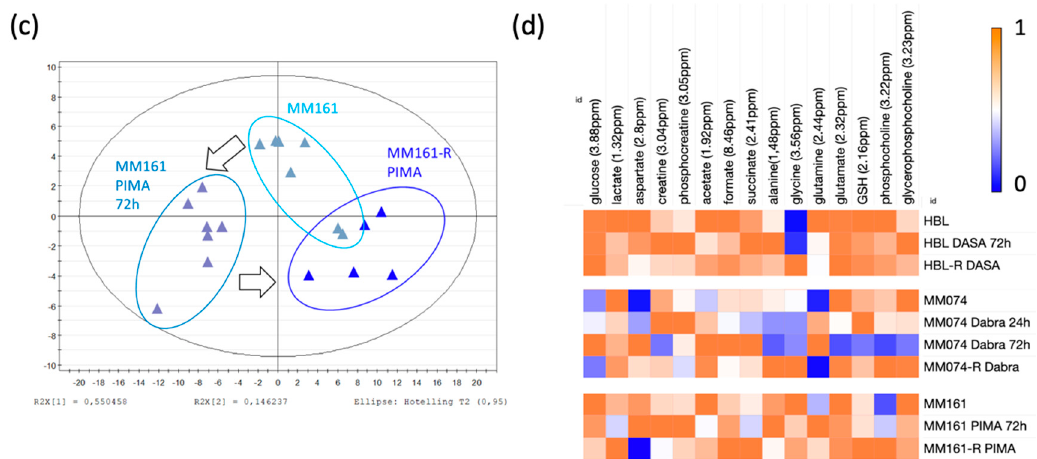
Figure 2. Scores plots highlighting the evolution of the IC metabolic signatures from an initial parental to a resistant status, in the case of mutant cKIT ( a ), mutant BRAF ( b ), and mutant NRAS ( c ) acquired resistance. Arrows were used to draw the metabolic switches followed by sensitive cells during resistance acquisition and exposed or not to targeted treatments. ( d ) Heatmap of the 15 IC discriminant metabolites identified between the 3 considered cell lines. Data normalization from [0 to 1] for each metabolite, enabling the metabolic signature investigation within and between the groups.